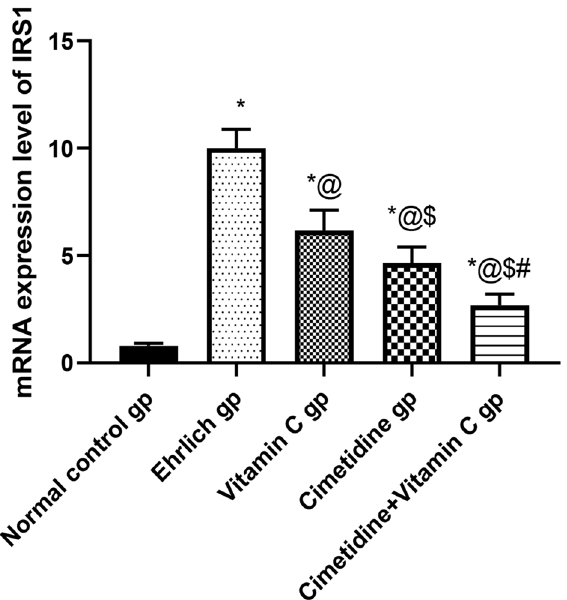
Figure 10. The relative mRNA expression level of IRS-1 following treatment with cimetidine at a dose of 200 mg/kg/day, vitamin C at a dose of 4 g/kg/day, and their combination for 15 days after Ehrlich induction of breast cancer in mice. Data are presented as mean ± SD.* is significantly different from the normal control group, P < 0.05. @ is significantly different from Ehrlich untreated group, P < 0.05. $ is significantly different from the vitamin C- treated group, P < 0.05. # is significantly different from cimetidine-treated group, P <